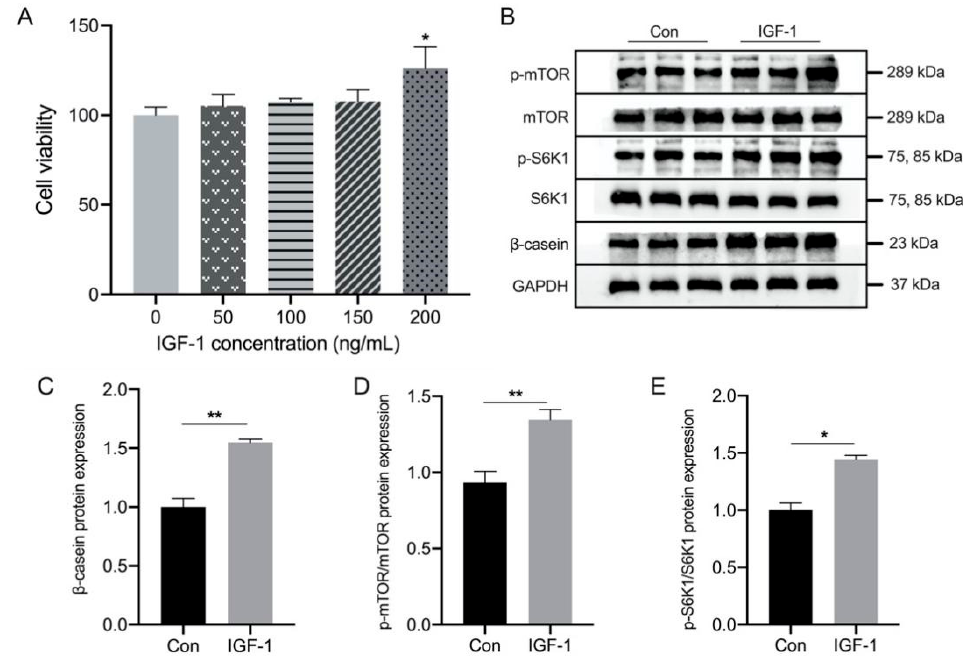
Figure 5. Effects of IGF-1 concentration on cell viability and protein expression of β -casein in bovine mammary epithelial cells (BMEC). ( A ) Relative cell viability after IGF-1 treatment. ( B ) Representative Western blotting of β -casein, p-S6K1, S6K1, p-mTOR, and mTOR. Protein abundance of the ( C ) β -casein, phosphorylation state, ( D ) p-S6K1/S6K1, and ( E ) p-mTOR/mTOR. This experiment was repeated 3 times, and data are reported as mean ± SEM. * p < 0.05 and ** p < 0.01. LMP: low milk protein concentration group; MMP: medium milk protein concentration group; HMP: high milk protein concentration group.